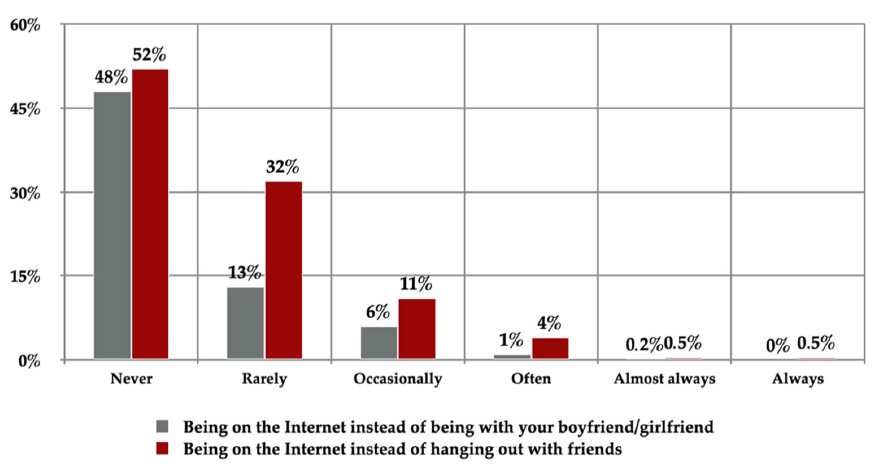
Figure 5. Preference for being online over being with a boyfriend/girlfriend or going out with friends.